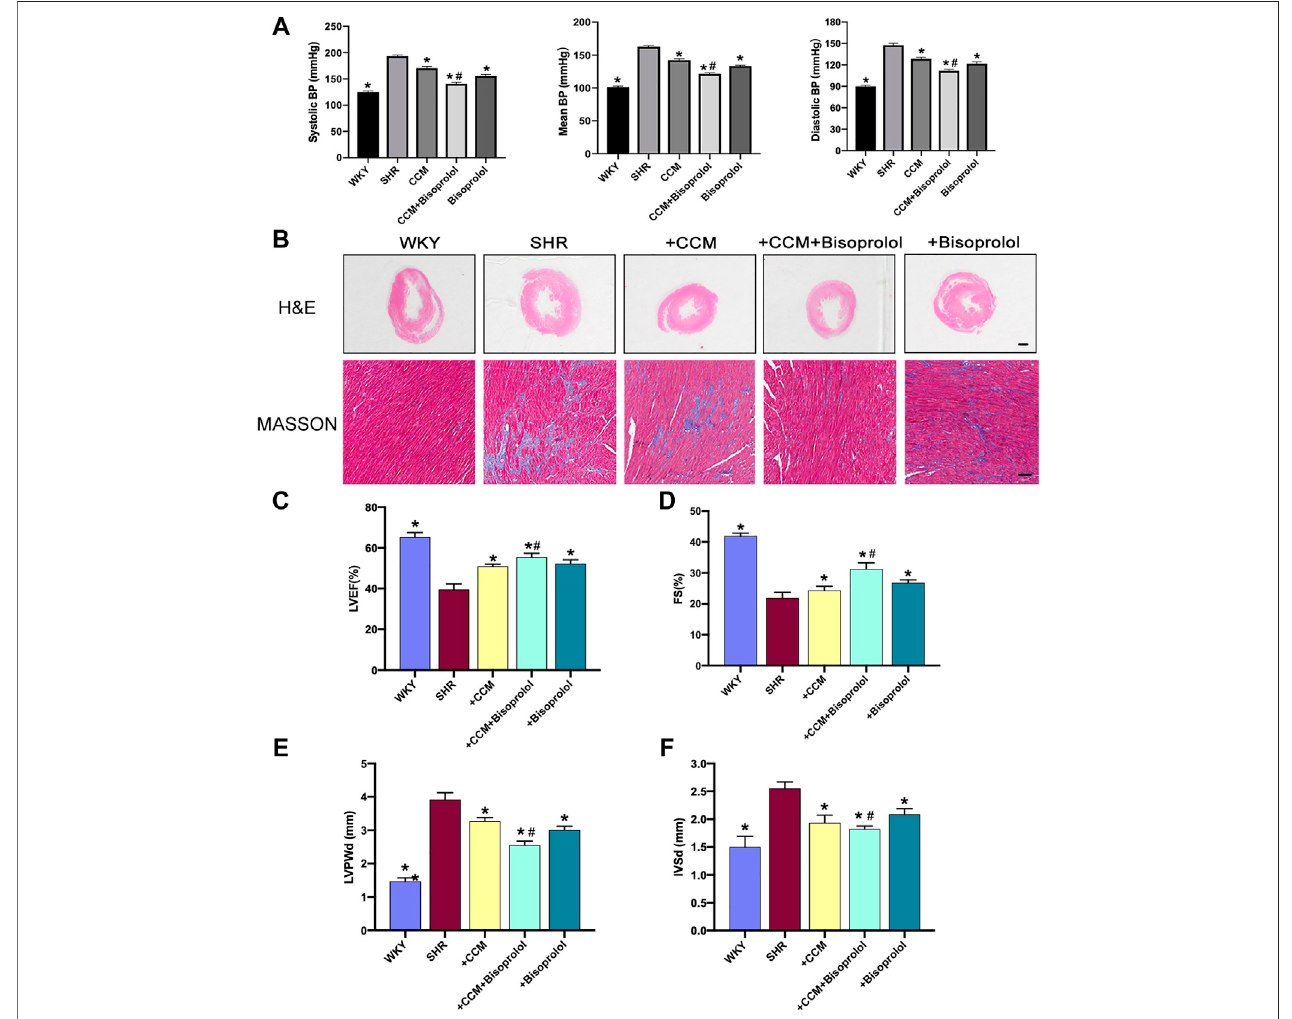
FIGURE 4 | CCM therapy promotes bisoprolol-produced protective effects on hypertension and myocardial remodeling in SHRs. Male SHRs at the age of 8 – 12 weeks old fed with normal diet received bisoprolol administration (5 mg/kg/day) or plus CCM therapy for 10 weeks. BP was measured by radio telemetry, as described in Materials and Methods. (A) Systolic BP, mean BP and diastolic BP; (B) HE staining, scale bar: 2mm; MASSON staining, scale bar:100 μ m; (C – F) Left ventricular ejection fraction (LVEF), Fractional shortening (FS), thickness of the left ventricular diastolic posterior wall (LVPWd), thickness of interventricular septum (IVSd).Eachexperimentwasrepeatedthreetimes.Quantitativeresultsareexpressedasmean±SEM.Nis10 – 15ineachgroup.* p < 0.05vs.SHRs.# p < 0.05vs.SHRs plus bisoprolol.